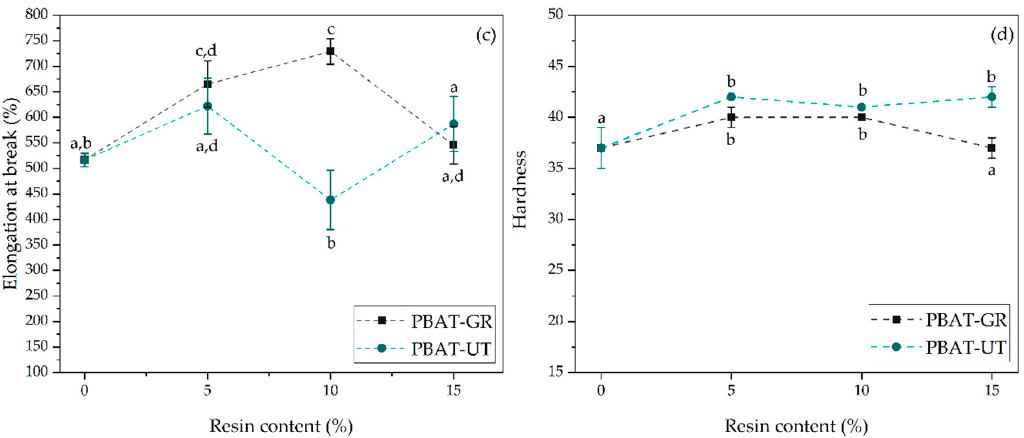
Figure 1. Effect of pine resin derivatives content on the tensile properties of PBAT resin-based formulations. ( a ) Young’s modulus, ( b ) tensile strength, ( c ) elongation at break, and ( d ) hardness. a–d Different letters within the same graph indicate statistically significant differences between formulations ( p < 0.05).